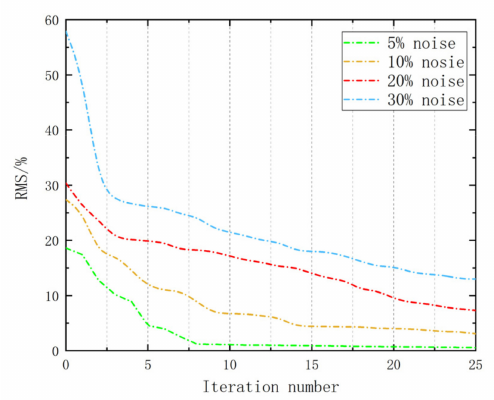
Figure 6. Convergence of the residual errors of the fits at different noise